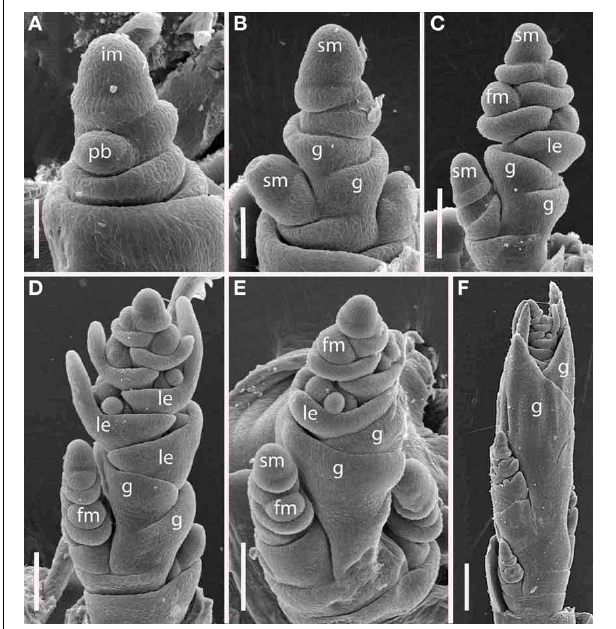
FIGURE 8 | Brachypodium distachyon (Brachypodieae). (A) Distichous primary branch formation; (B) inflorescence meristem and uppermost branch meristem converted to spikelet meristems; (C–F) , successive stages of development, showing differentiation of the terminal spikelet well ahead of the lateral spikelets. im, inflorescence meristem; pb, primary branch; sm, spikelet meristem, g, glume, le, lemma, fm, floral meristem. Scale bars: (A,B) , 50 µ m; (C–E) , 100 µ m; (F) , 200 µ m.